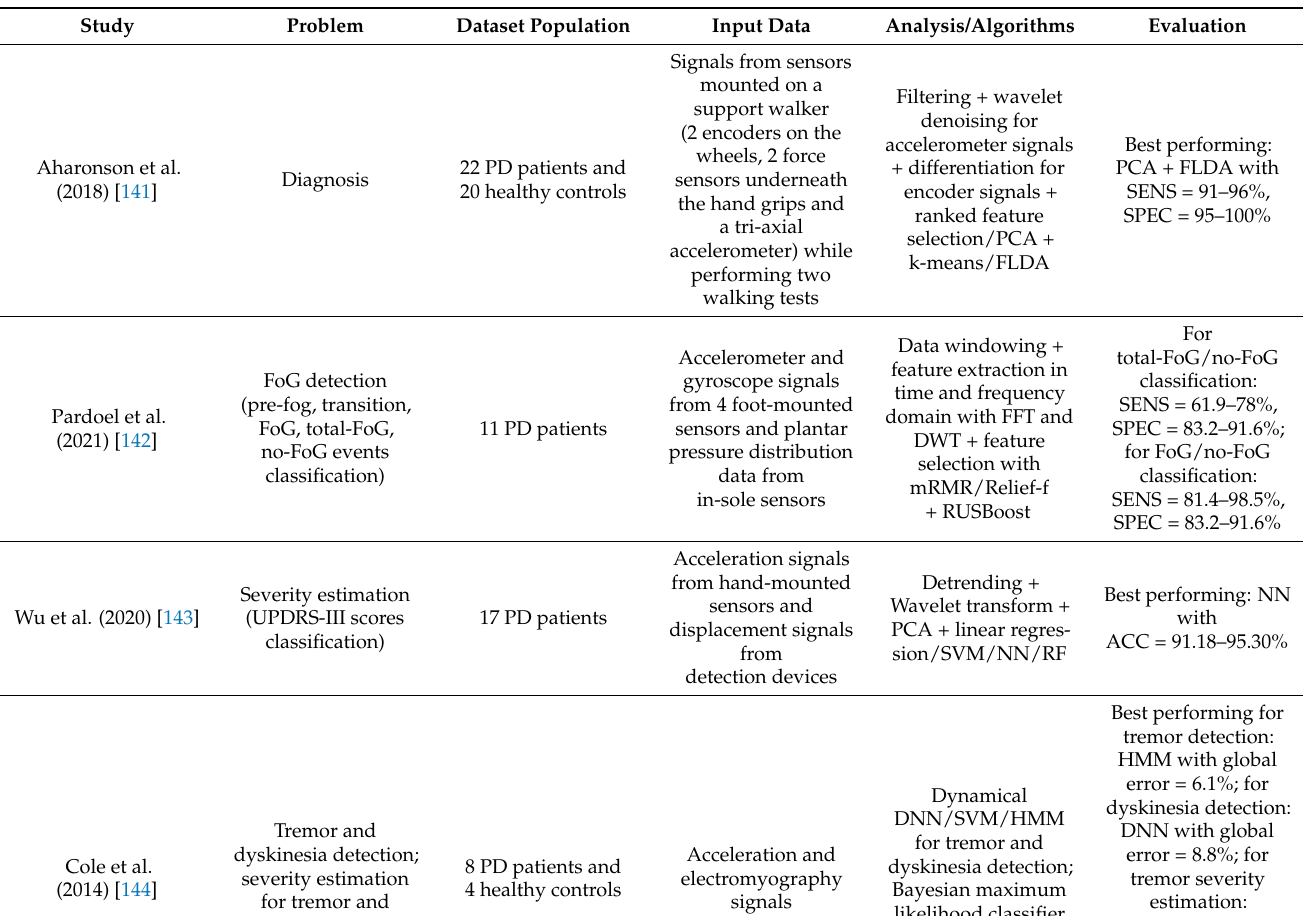
Table A6. Studies based on the combination of previous types of